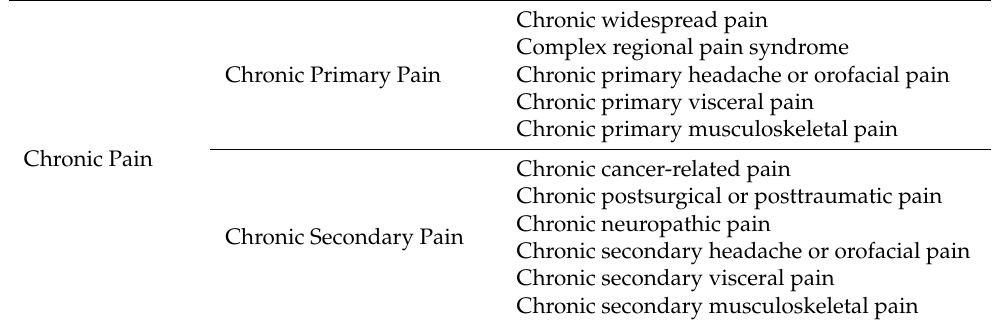
Table 1. The IASP classification of chronic pain (modified by